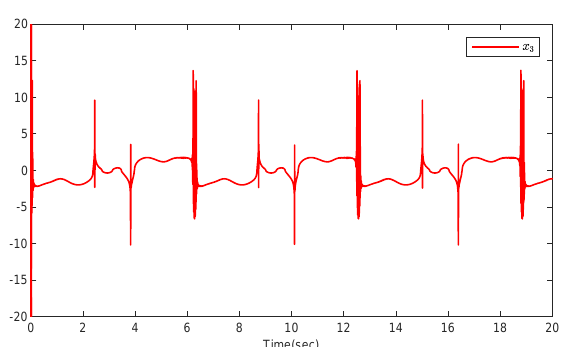
Figure 8. System state x 2 .